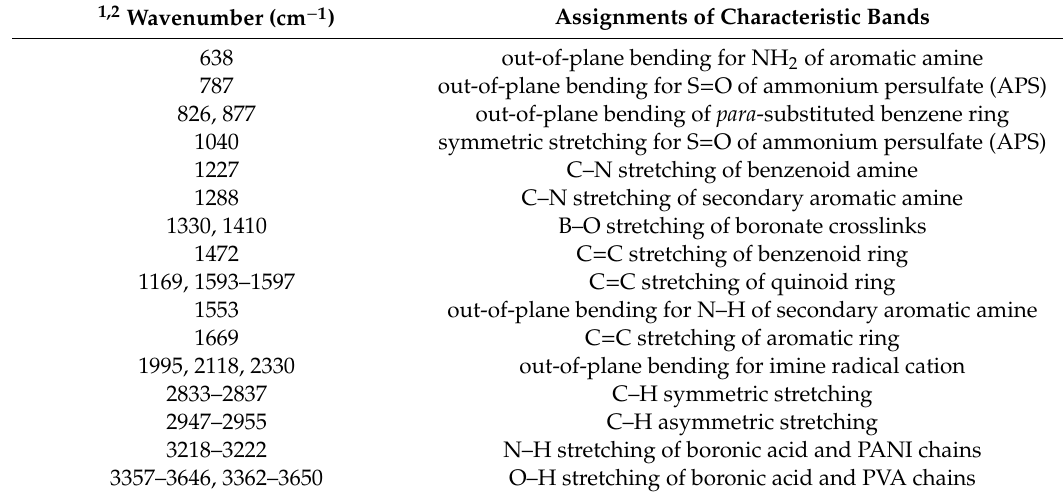
Table 3. IR absorption bands of PVA–PANI–MLG